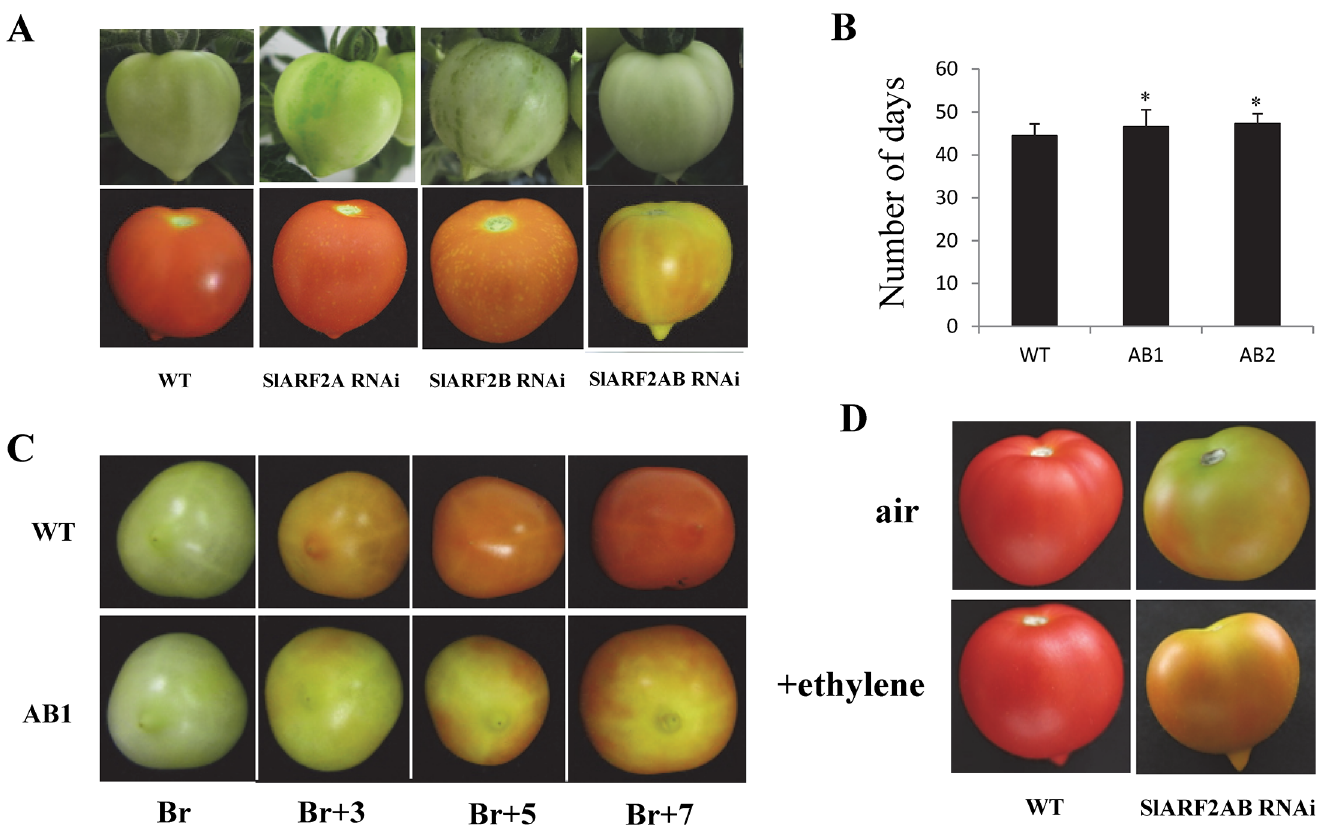
Fig 6. Altered ripening phenotypes of SlARF2 down-regulated lines. (A) Ripening phenotypes of SlARF2A-RNAi; SlARF2B-RNAi and SlARF2AB-RNAi fruits at mature green (upper panel) and ripe (lower panel) stages. The SlARF2A/SlARF2B-RNAi fruits show spiky phenotype at mature green stage and ripe stage fruits, SlARF2AB-RNAi mutant displays inhibited ripening. (B) Time (number of days) from anthesis to breaker in wild type and two independent SlARF2AB-RNAi lines. (C) Ripening phenotypes of wild-type (WT) and SlARF2AB-RNAi fruits. Transgenic fruits never reach a full red color. Br = breaker stage; Br+3 = 3 days post-breaker stage; Br+5 = 5 days post-breaker stage; Br+7 = 7 days post-breaker stage. (D) Effect of ethylene treatment on wild type (WT) and SlARF2AB-RNAi fruit. Mature green fruits from WT and SlARF2AB-RNAi lines were treated 2 hours and 3 times per day with 10 ppm ethylene or with air for 3 days. After 7 days, both ethylene treated and untreated wild type fruit reached full red while SlARF2AB-RNAi fruits treated or untreated displayed orange sectors on the fruit surface and never get red.